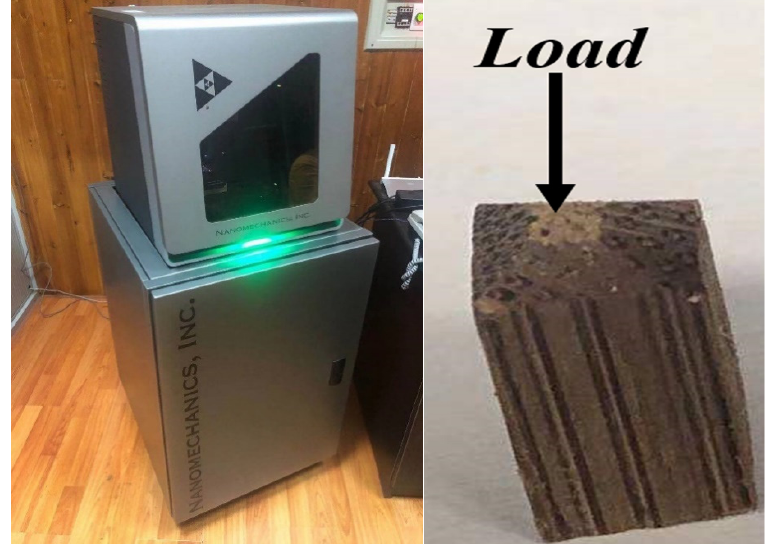
Figure 2. Nanomechanics ( left ) and sample ( right